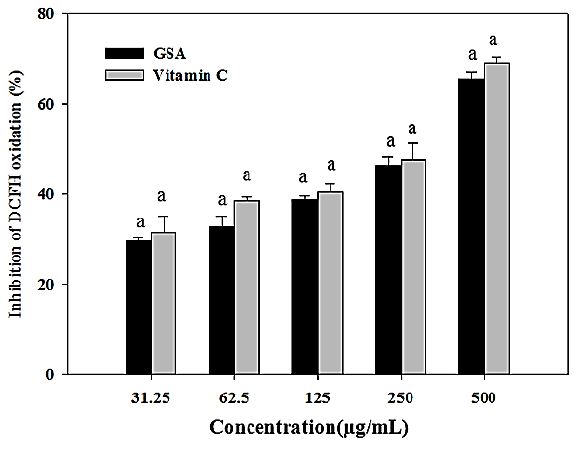
Figure 3. Protective efffect of GSA against oxidative damage on isolated mouse liver mitochondria. ROS generation was assayed as inhibition of DCFH oxidation. Values represent the mean ± SD ( n = 3). Columns with different letters are significantly different at p < 0.05